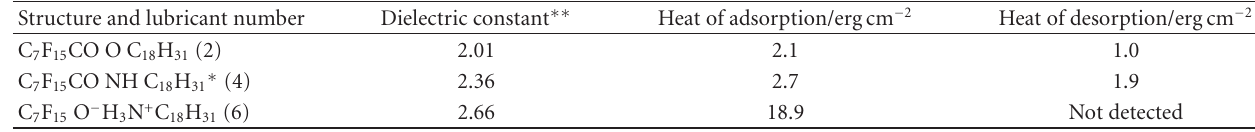
Table 7: Heat of adsorption and desorption of the lubricants on the surface. Structure and lubricant